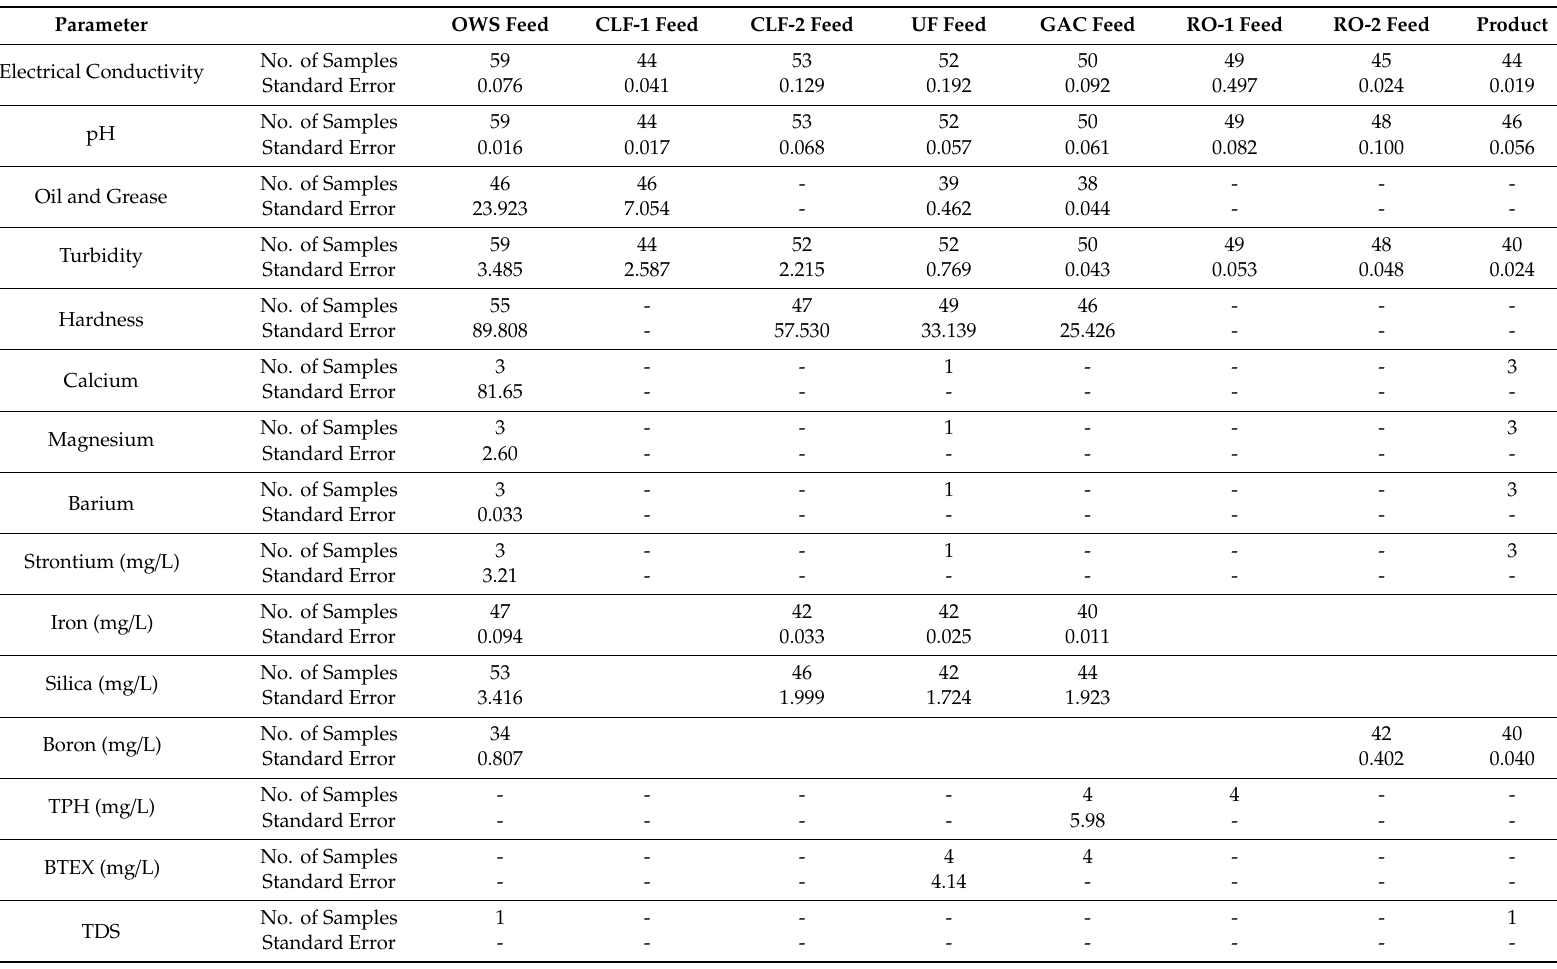
Table A3. Number of Sampling Events and Standard Errors for Data Presented in Table